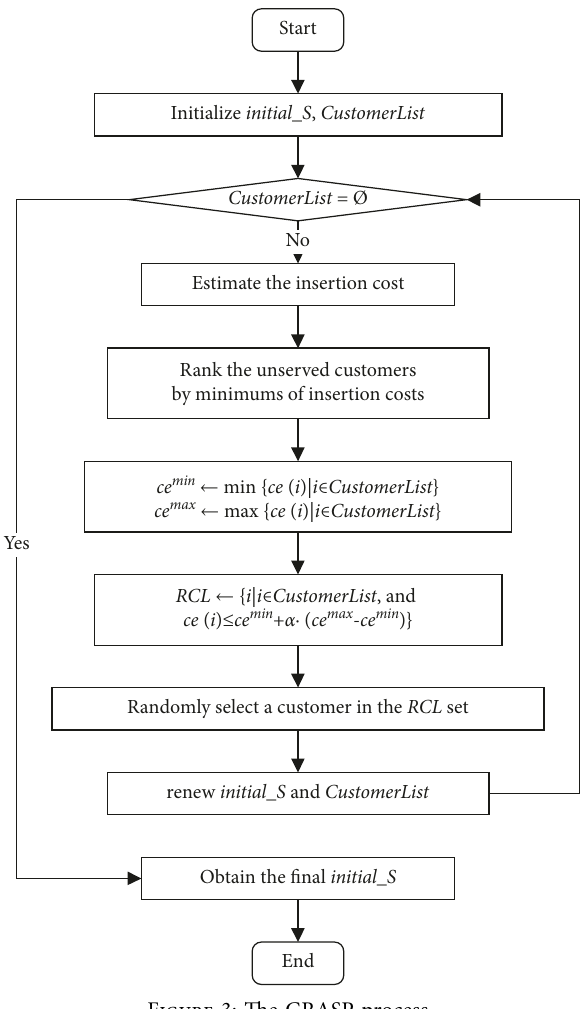
Figure 3: The GRASP